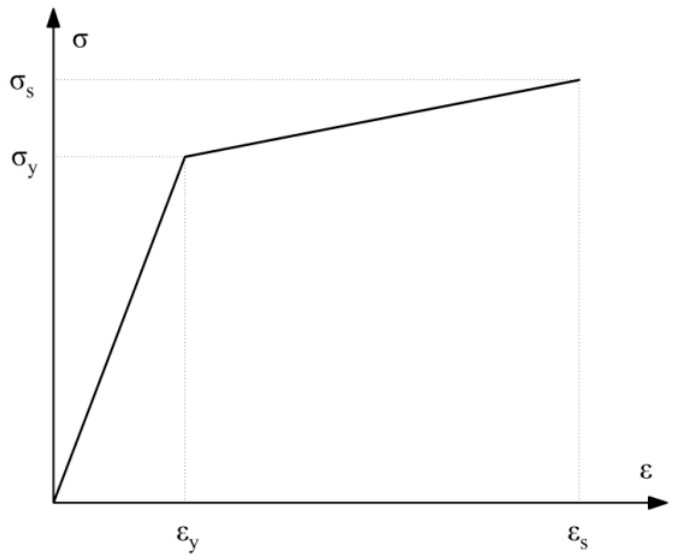
Figure 12. Materials’ constitutive model.